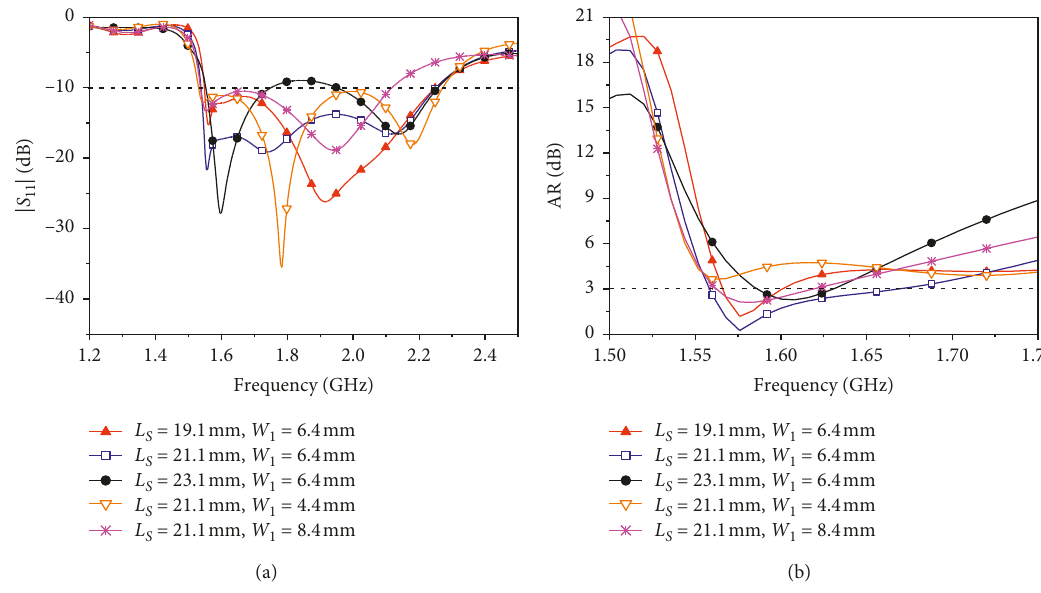
Figure 5: Variations of (a) | S 11 | and (b) AR with different dimensions of center strip, L s and W 1 .